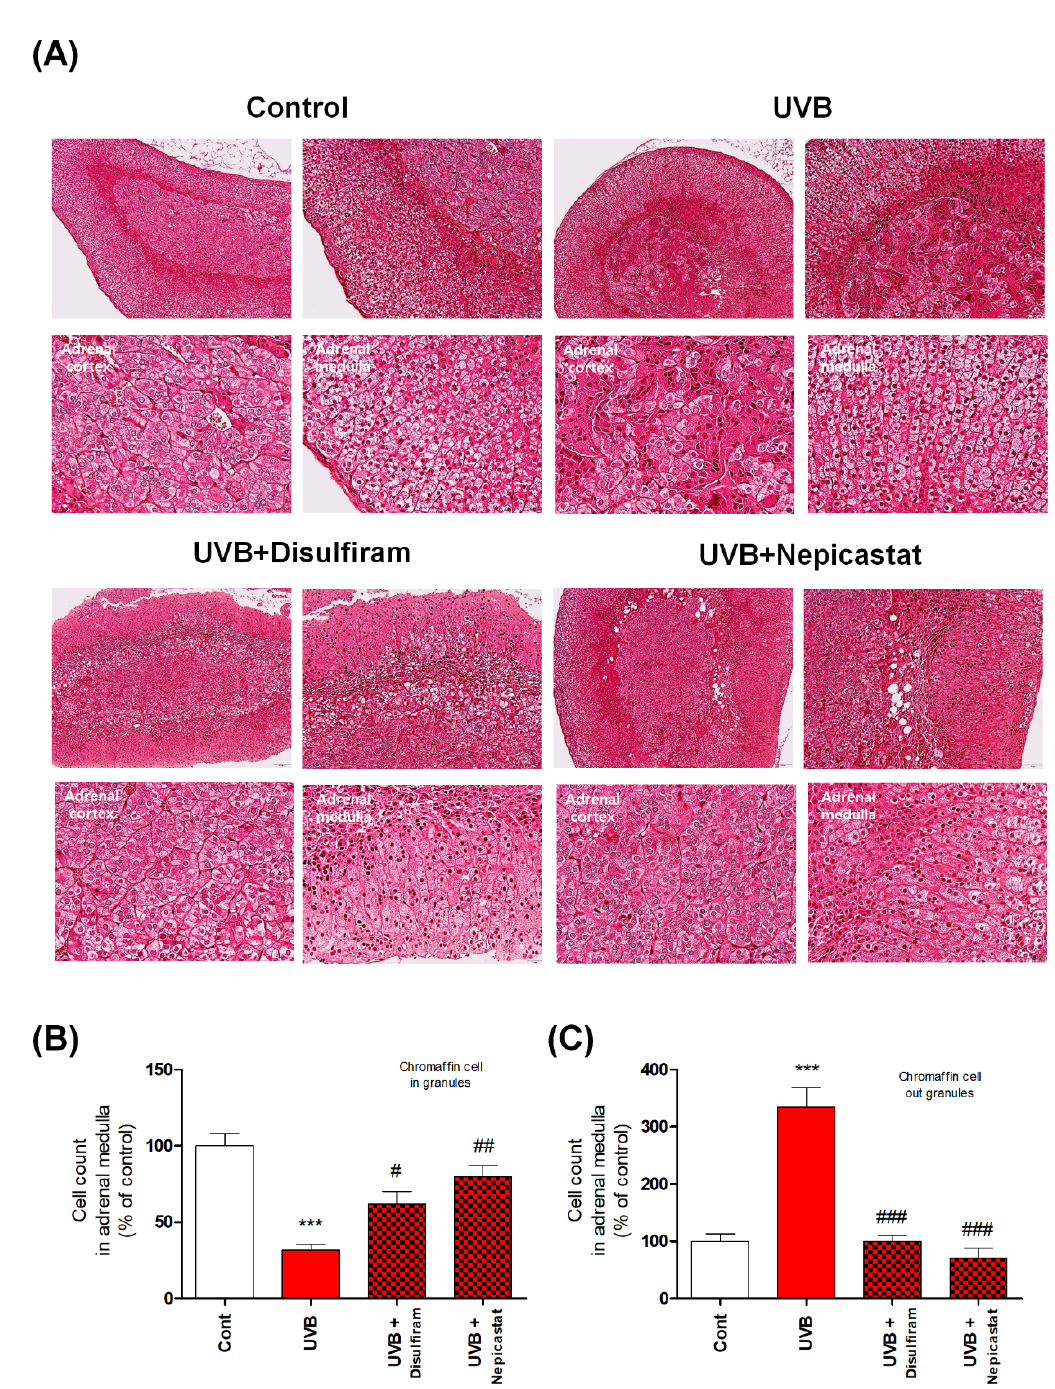
Figure 4. Protective effects of dopamine- β -hydroxylase (D β H) inhibitors against cytotoxic damage to the chromaffin cells of the adrenal medulla caused by skin exposure to chronic excessive UVB. ( A ) Representative histological analysis of an adrenal gland section damaged by exposure to UVB. ( B , C ). H&E staining was used to identify chromaffin cell counts in granules. Values represent the mean ± standard error of the mean. Statistical significance of differences is illustrated as follows: *** p < 0.001 compared with the control group and # p < 0.05, ## p < 0.01, and ### p < 0.001 compared with the UVB group.